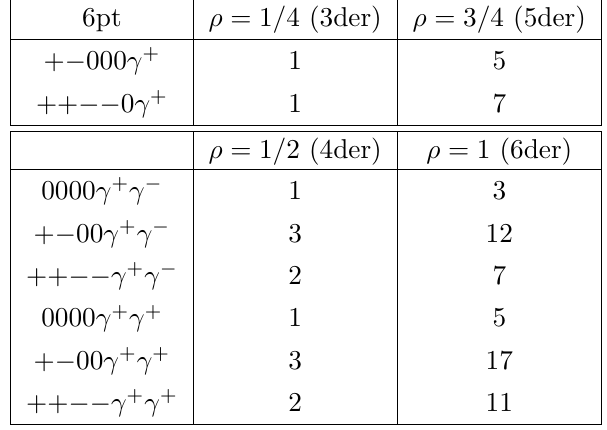
Table 4 . Number of independent monomials for 6pt vertices with one or two